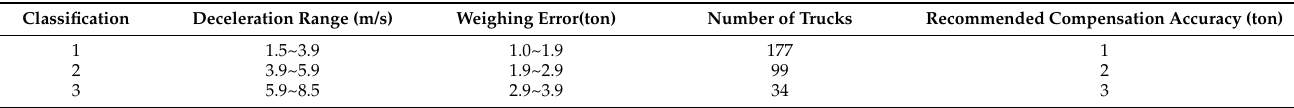
Table 3. Distribution of weighing accuracy for truck deceleration range.